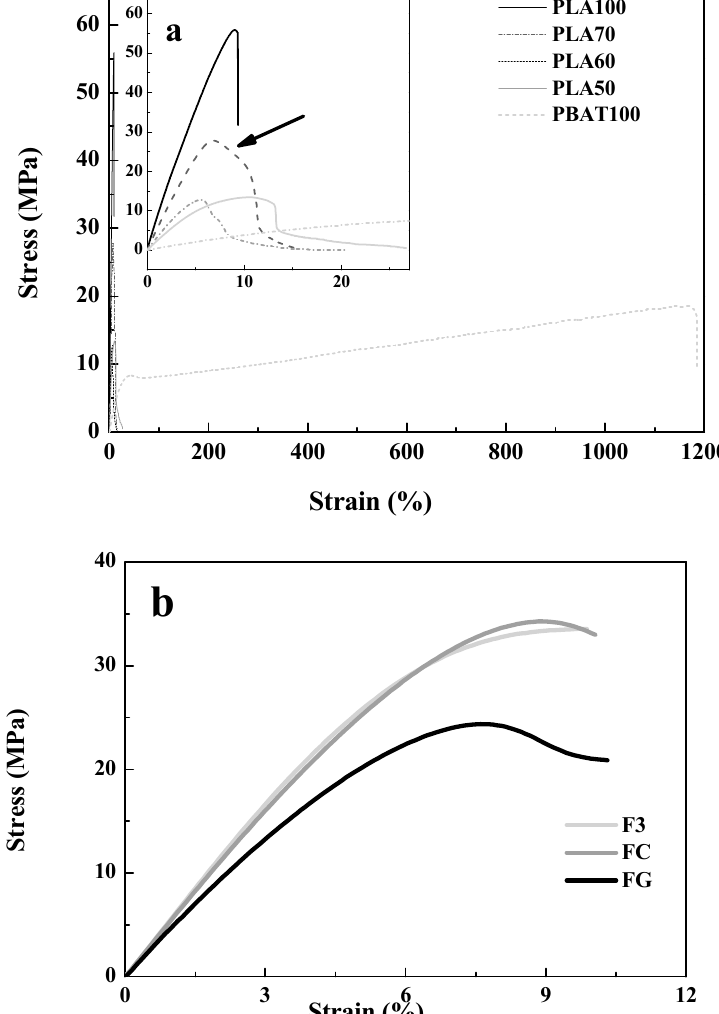
Figure 6. Stress–strain curves of: ( a ) Homopolymers and their blends and ( b ) bio-based polymer fibers.